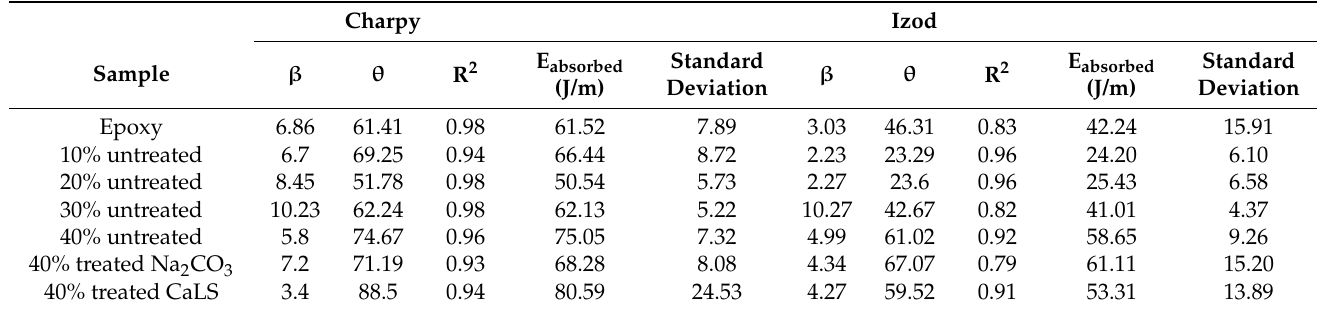
Table 3. Weibull parameters for resistance to Impact Charpy and Izod of untreated and treated TV fibers